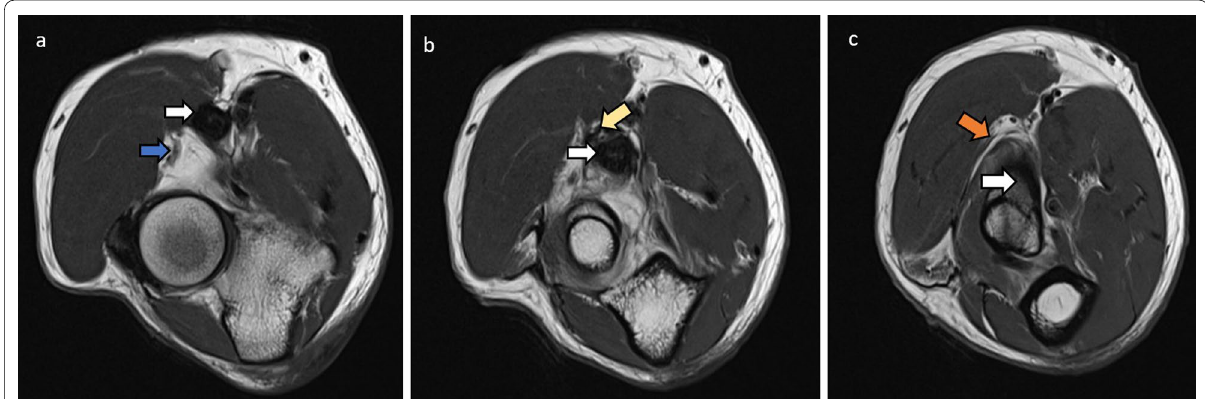
Fig. 7 Stack of PD axials of the upper forearm of a 55-year-old male post distal biceps tendon repair. The biceps tendon ( a , b , c , white arrows) is intact although thickened just proximal to the tunnel entry. The radial nerve above the elbow appears normal ( a , blue arrow). The superficial branch ( b , yellow arrow) comes close to scarring around the enlarged biceps tendon and appears adherent. The deep branch ( c , orange arrow) continues without abnormality to the